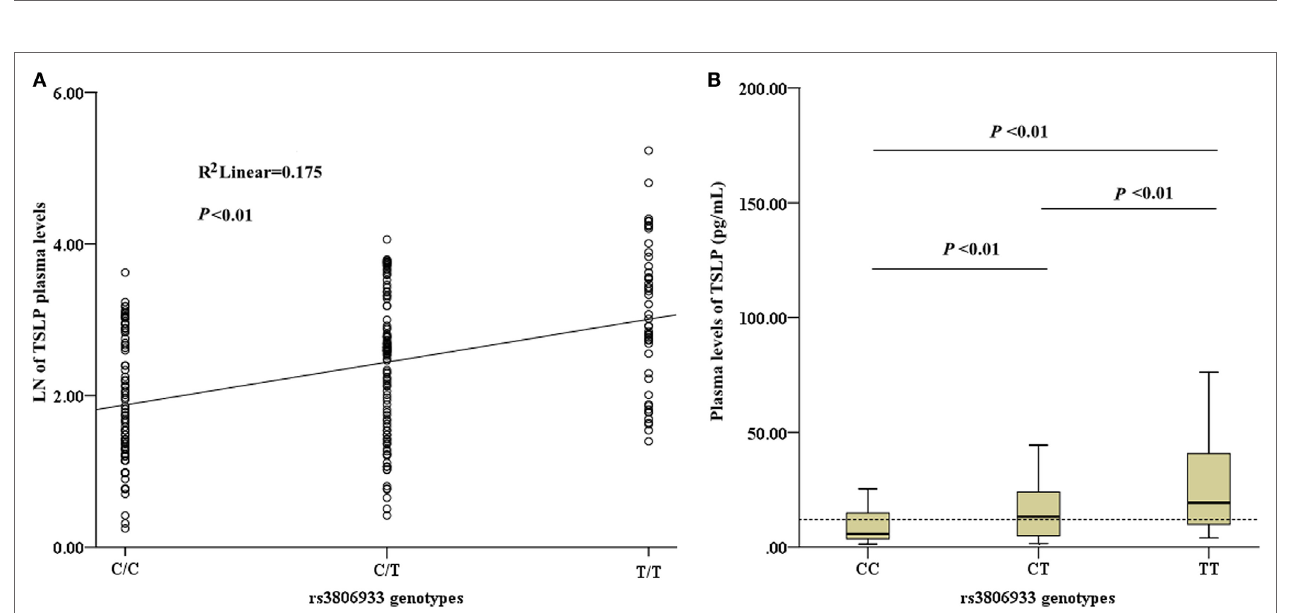
FigUre 2 | Reporter gene analysis for thymic stromal lymphopoietin ( TSLP ) (a) and interleukin 7 receptor ( IL7R ) (B) . Luciferase activity was tested by means of cellular extracts. Mean ± SD of the relative luciferase activity is shown. The difference in the luciferase activity among the reference plasmids was analyzed using the ANOVA test. The terminology of P < 0.01 indicates statistical